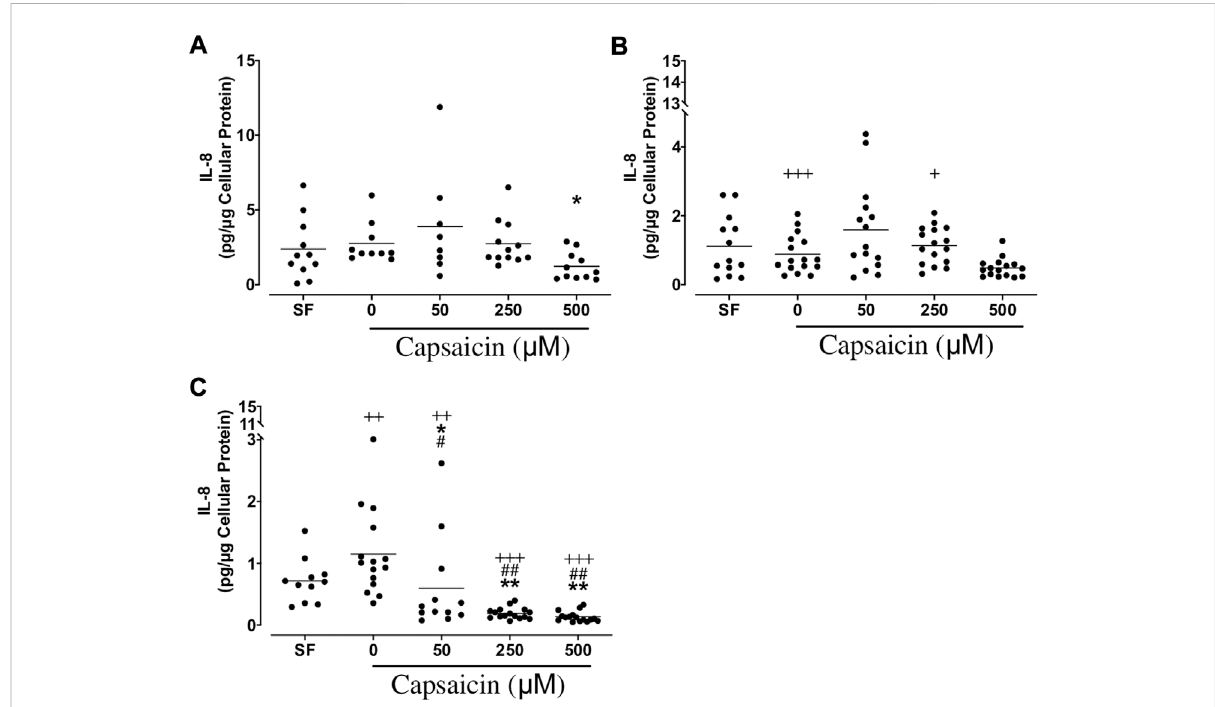
FIGURE 5 Effect of capsaicin on interleukin (IL)-8 release from bronchial epithelial cells of non-smokers (A) , smokers (B) and patients with COPD (C) . Individualdatapointswithmeansweredisplayedfornon-smokers,smokersandpatientswithCOPD(* p < 0.05,** p < 0.0001vs.0 μ Mcapsaicin;+ p < 0.05,++ p < 0.01,+++ p < 0.0001vs.non-smokers;# p < 0.05, ## p < 0.001vs.smokers). SF,serumfreetreatedcells;0 µMindicatesethanol,solvent for